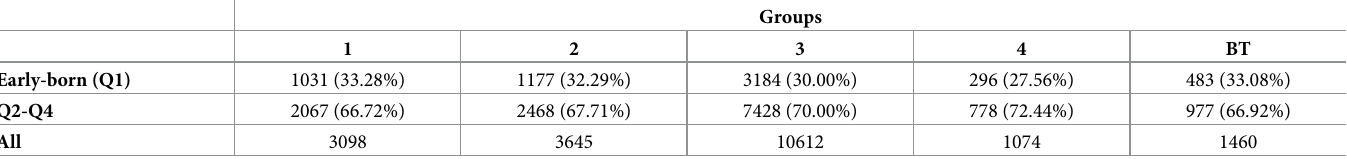
Table 1. Distribution of “early-born” players in various groups.